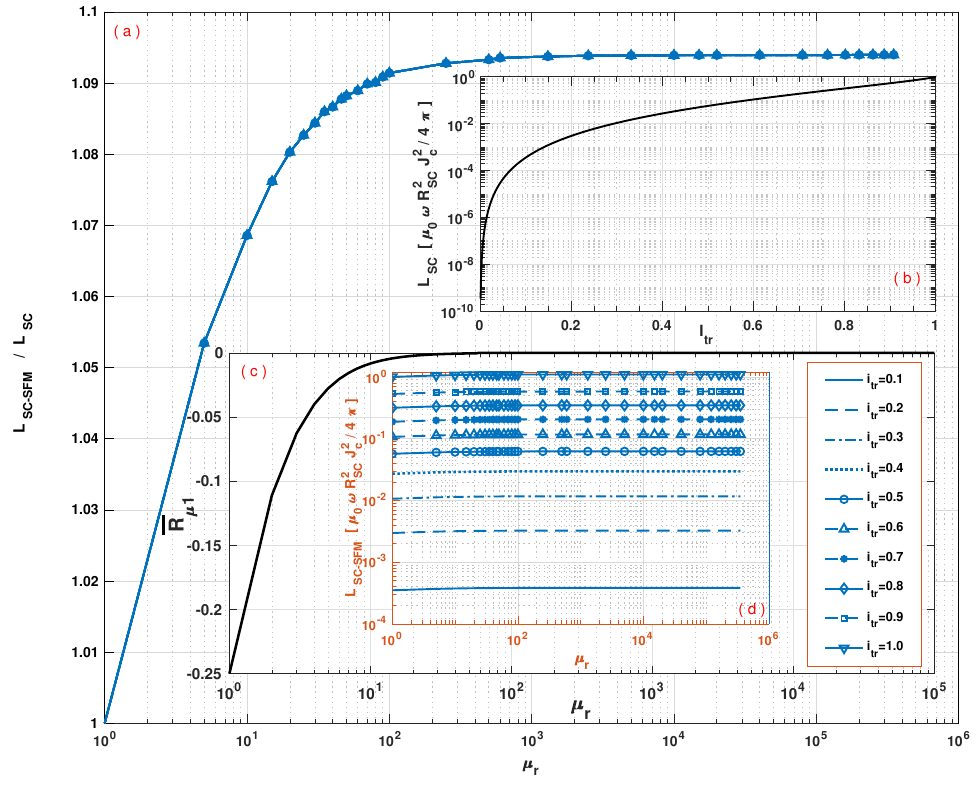
Figure 5. ( a ) Hysteretic losses ratio between SC-SFM metastructures ( L SC − SFM ) and the AC losses produced by an isolated SC wire ( L SC ) of cylindrical cross section as a function of the relative magnetic permeability µ r of the SFM with R SFM = 1.5 R SC . ( b ) The top inset shows the well known analytical solution for L SC as a function of I tr [47,51,60]. ( c ) The bottom outer inset shows the numerical tendency of the non-dimensional factor ¯ R µ 1 (Equation (16)) valid for any radius of the SFM sheath up to R SFM = 10 R SC and with magnetic permeabilities from µ r ∼ 1 up to 1 × 10 5 . ( d ) Finally, the inner inset shows the dependence of the metastructure losses ( L SC − SFM ) for different amplitudes of the transport current i tr in units of I c , and the relative magnetic permeability of the SFM sheath µ r